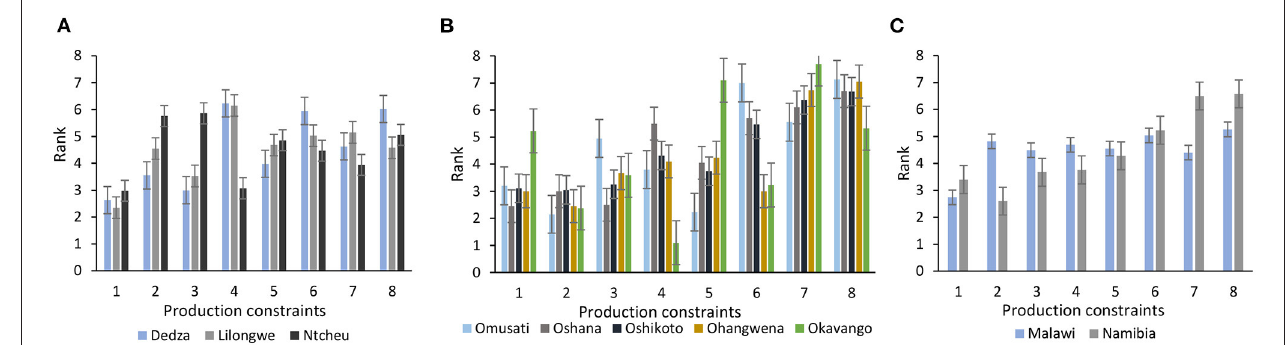
FIGURE 1 | Comparison of the ranking of the production constraints amongst smallholder farmers from the three districts of central Malawi (A) , five regions of northern Namibia (B) , and the means of the countries (C) using Friedman’s test: On the x-axis; 1 = Lack of seed, 2 = Low soil fertility, 3 = Poor germination, 4 = Drought, 5 = Lack of inputs, 6 = Insect pests, 7 = Lack of markets and 8 = Diseases.